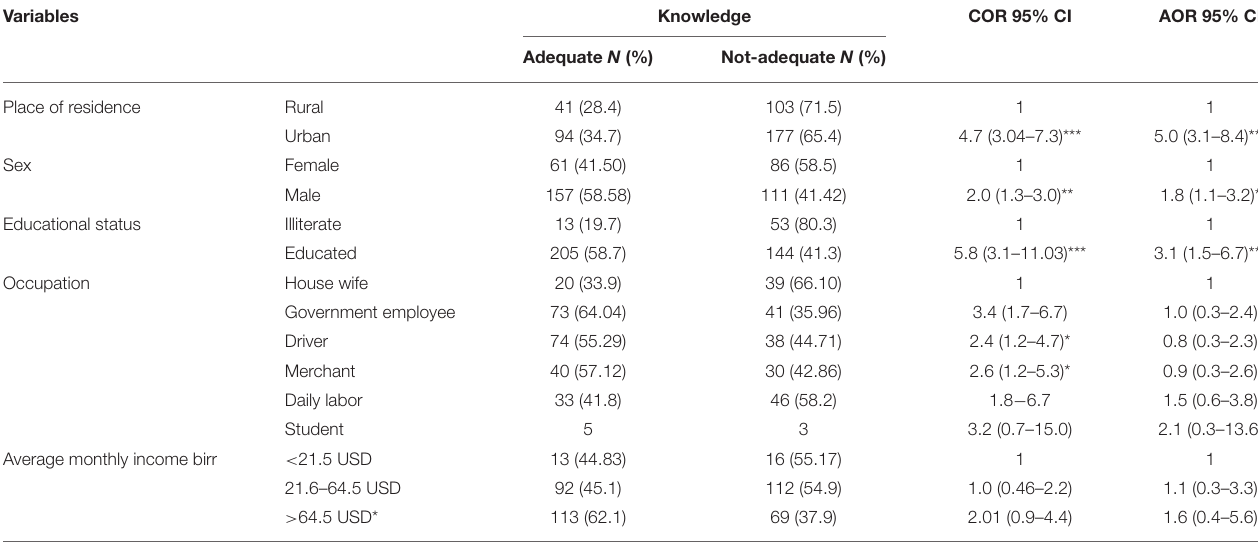
TABLE 5 | Factors associated with knowledge toward COVID-19 among Dire Dawa administration residents, Eastern Ethiopia May